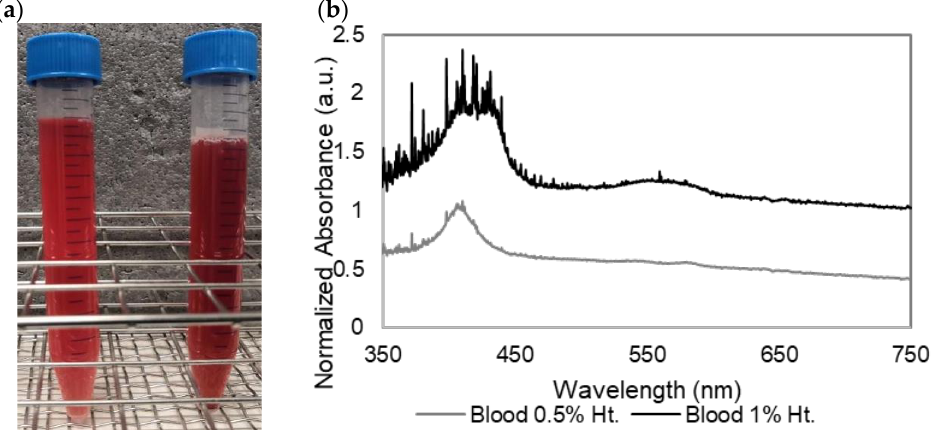
Figure 7. ( a ) Samples of RBCs in Dextran 40 at a hematocrit of 0.5%, on the left, and 1%, on the right, used in this study, and respective ( b ) normalized absorbance spectra (a.u.) in the 350–750 nm optical range.